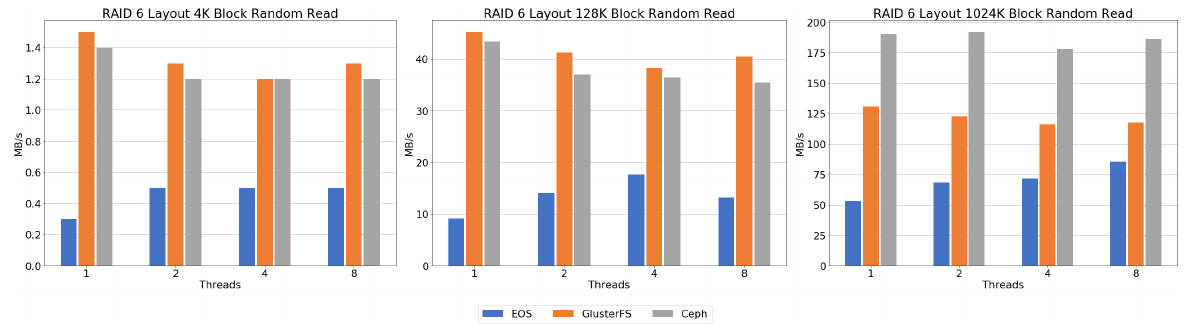
Figure 16. RAID 6-like layout—random read result.